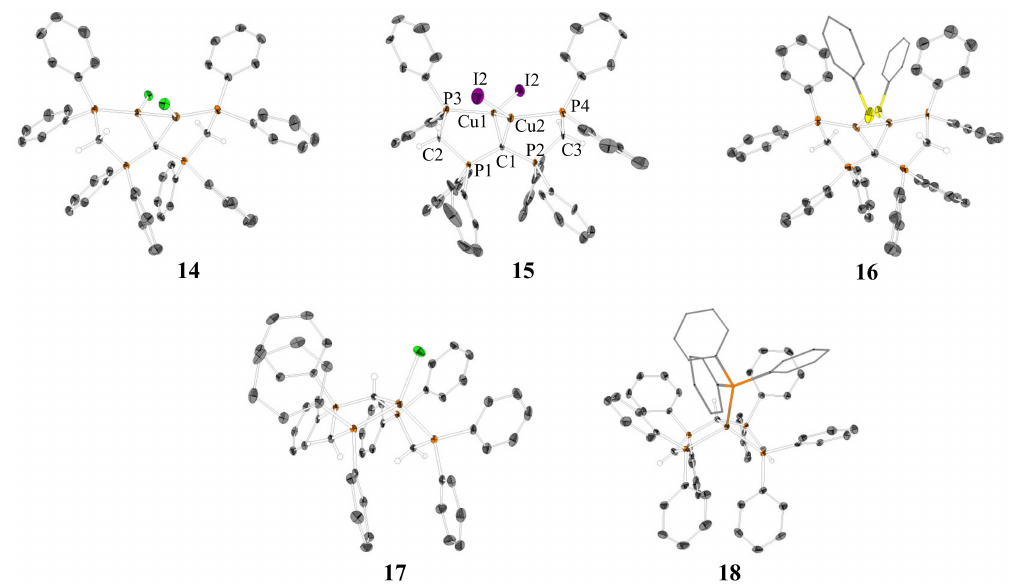
Figure 2. XRD molecular structures of [(CuCl) 2 (CDP(CH 2 PPh 2 ) 2 ] ( 14 ), [(CuI) 2 (CDP(CH 2 PPh 2 ) 2 ] ( 15 ), [(CuSPh) 2 (CDP(CH 2 PPh 2 ) 2 ] ( 16 ), [CuCl(H-CDP(CH 2 PPh 2 ) 2 ]PF 6 ( 17 ), and [CuPPh 3 (CH(PPh 2 CHPPh 2 ) 2 ] ( 18 ). Hydrogen atoms and solvent molecules have been omitted for clarity; thermal ellipsoids are given at 50% probability. For 17 , the counter anion [PF 6 ] − is omitted for clarity. The labeling of 15 is identical for all species. For more details, see the Supplementary